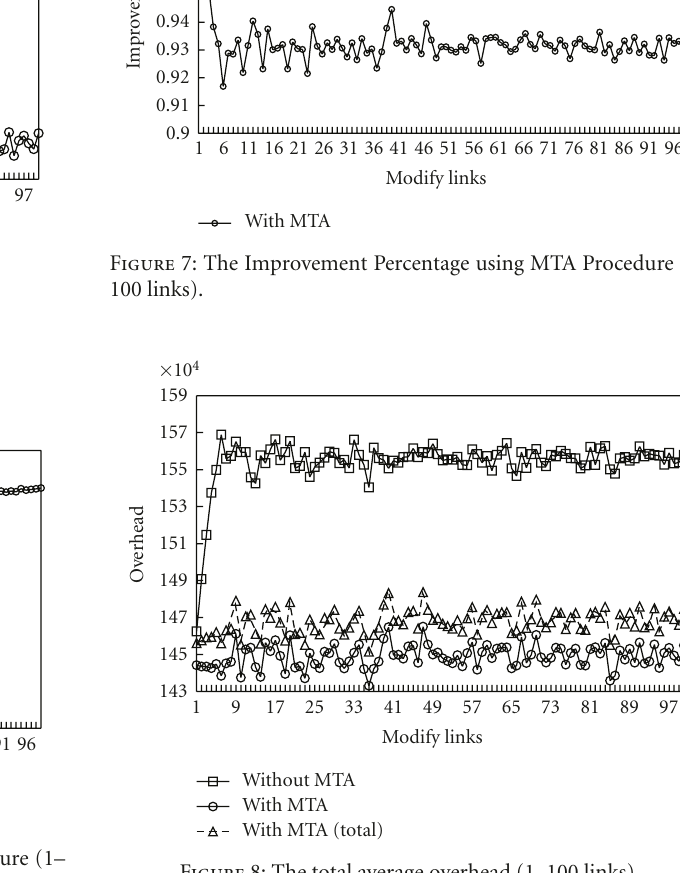
Figure 8: The total average overhead (1–100